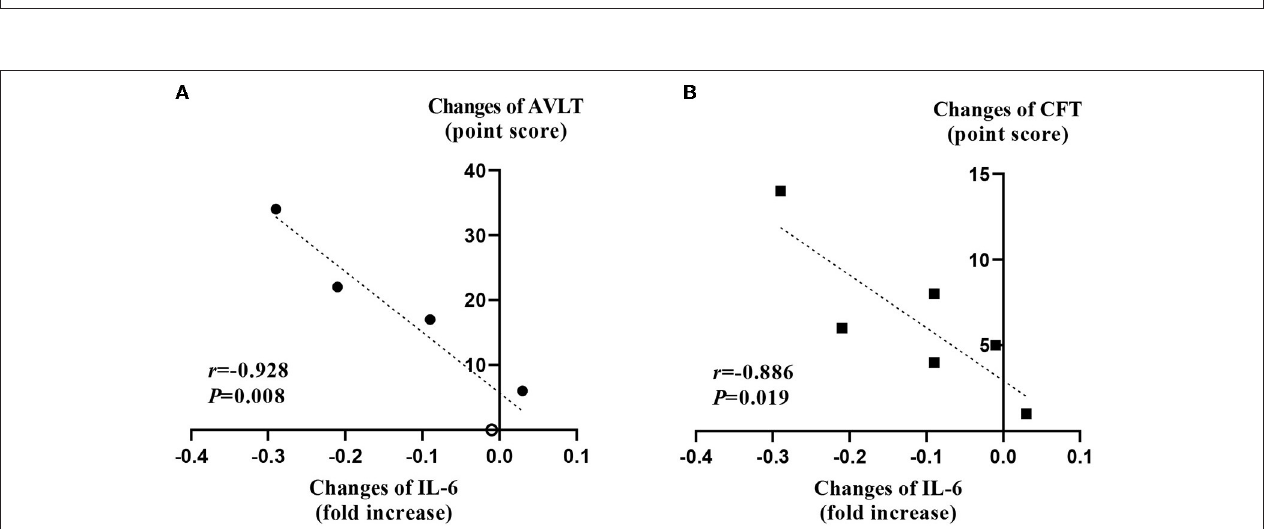
FIGURE 3 | Correlation analysis between changes of interleukin-6 and cognitive function test. (A) The change of the IL-6 negatively correlated with the change of the score of AVLT test after 2 weeks of rTMS treatments. The empty circle indicates an overlapped value from two different patients. (B) The change of the IL-6 negatively correlated with the change of the score of CFT test after 2 weeks of rTMS treatments. These figures depict results of 6 patients. IL-6, interleukin-6; AVLT, auditory verbal learning test; CFT, complex figure test.